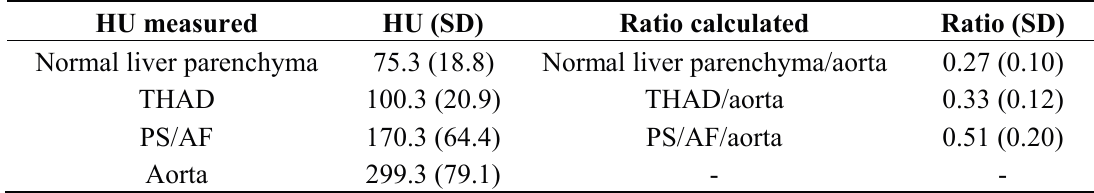
Table 2. Mean values and calculated ratios along with SD.